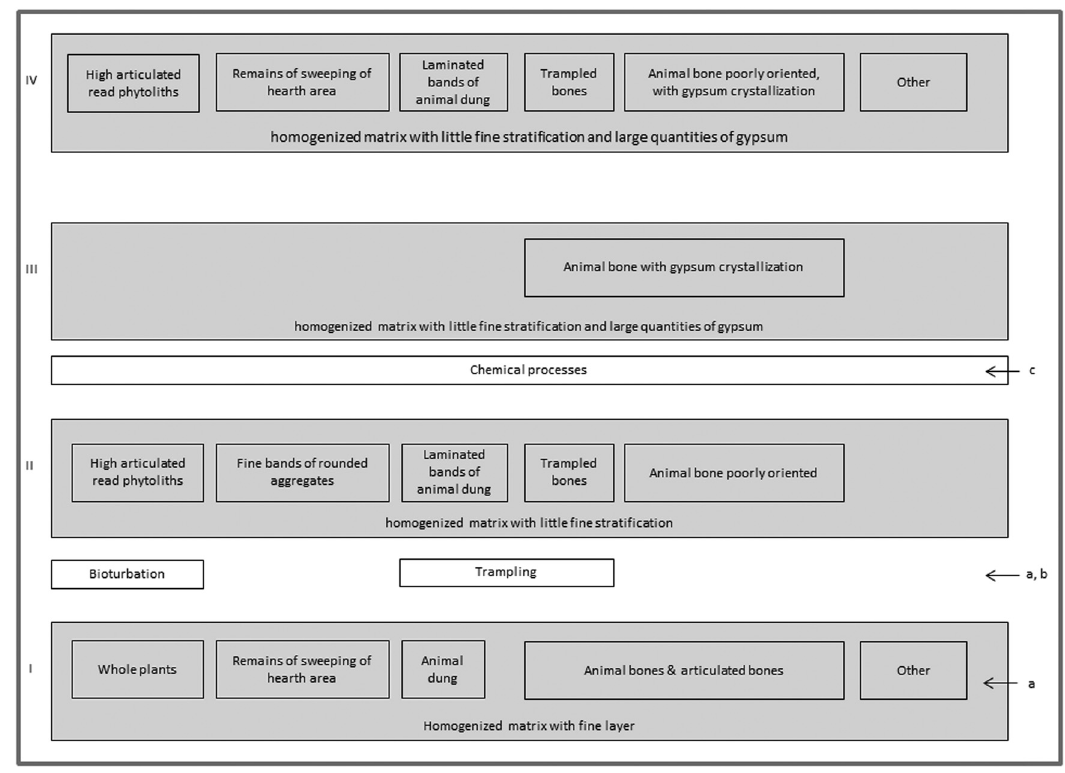
Figure 15: Reconstruction of possible midden formation process ( Çatalhöyük East, TP Area, Level TP.Q ) . Explanation: I – IV successive stages; taphonomic processes occur between them. Stage I: discarded ecofacts and artefacts; Stage II: observed characteristics; Stage III: the impact of chemical processes; Stage IV: characteristics of excavated midden; ( a – c ) impact on the assemblage: ( a ) human activity; ( b ) animal activity; and ( c ) environmental condition including climate. The “ Other ” category includes charcoal, microcharcoal, human bones, pottery, and architectural